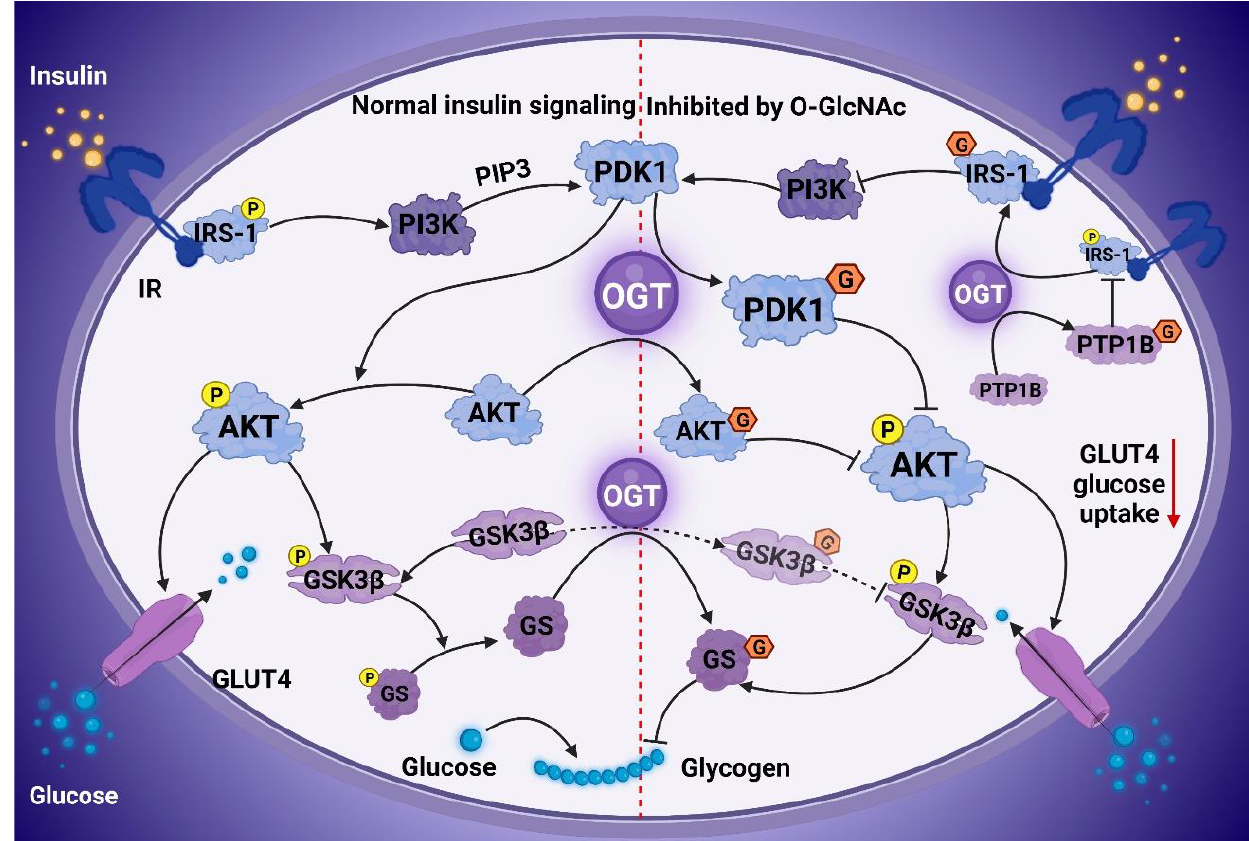
Figure 2. O-GlcNAcylation attenuated insulin signaling. Normal insulin signaling (Left). Insulin